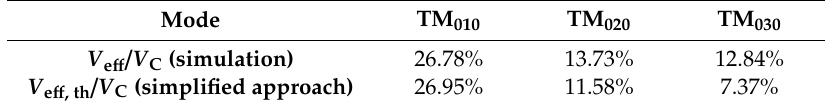
Table 1. Comparison of the modal volumes of the TM 010 , TM 020 , and TM 030 modes of the resonator.